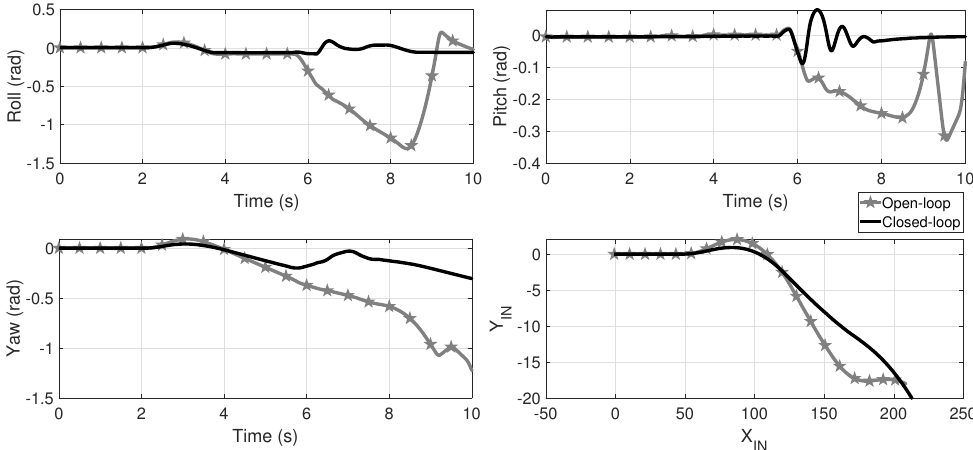
Figure 12. Comparative of the roll, pitch and yaw angles as well as the TWV displacement for open (black plots) and closed-loop (gray, star marked plots) for the maneuver of Figure 2a augmented by 300%. Also, µ = 0.6 l f = 0.882 m, l r = 1.143 m, h = 0.432 m, b r = 0.625 m, bl = 0.425 m and m = 597 kg. At second 5.6, a speed bump is simulated by an exogenous road step (Figure 2b) in the front wheel and 0.1 seconds later in the rear right wheel. In open-loop the vehicle suffers a rollover from second 6 as the roll angle indicates and in closed-loop the rollover is avoided despite the parametric variation; since the three wheel loose ground contact at second 5.8 oscillations are expected at TWV landing. In the Supplementary Material Section, a link is provided to video